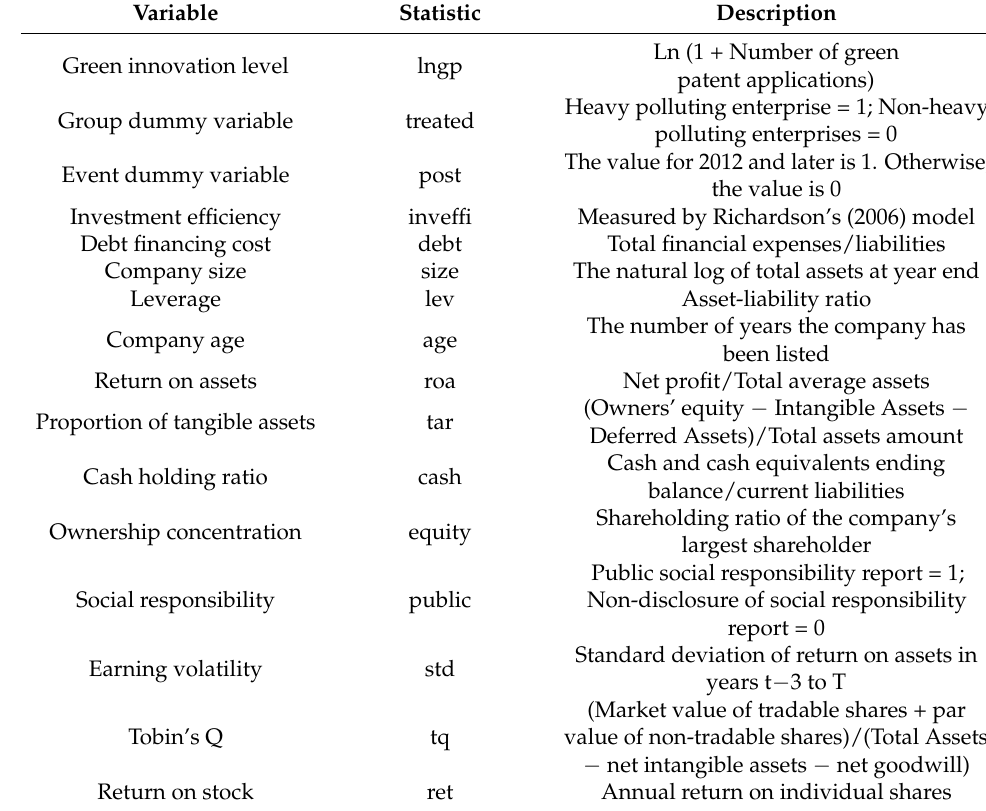
Table 1. Variable